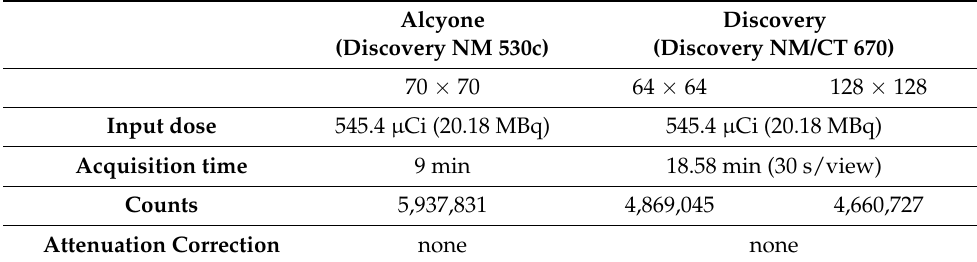
Table 2. Acquisition parameters used for scanning the NEMA phantom.